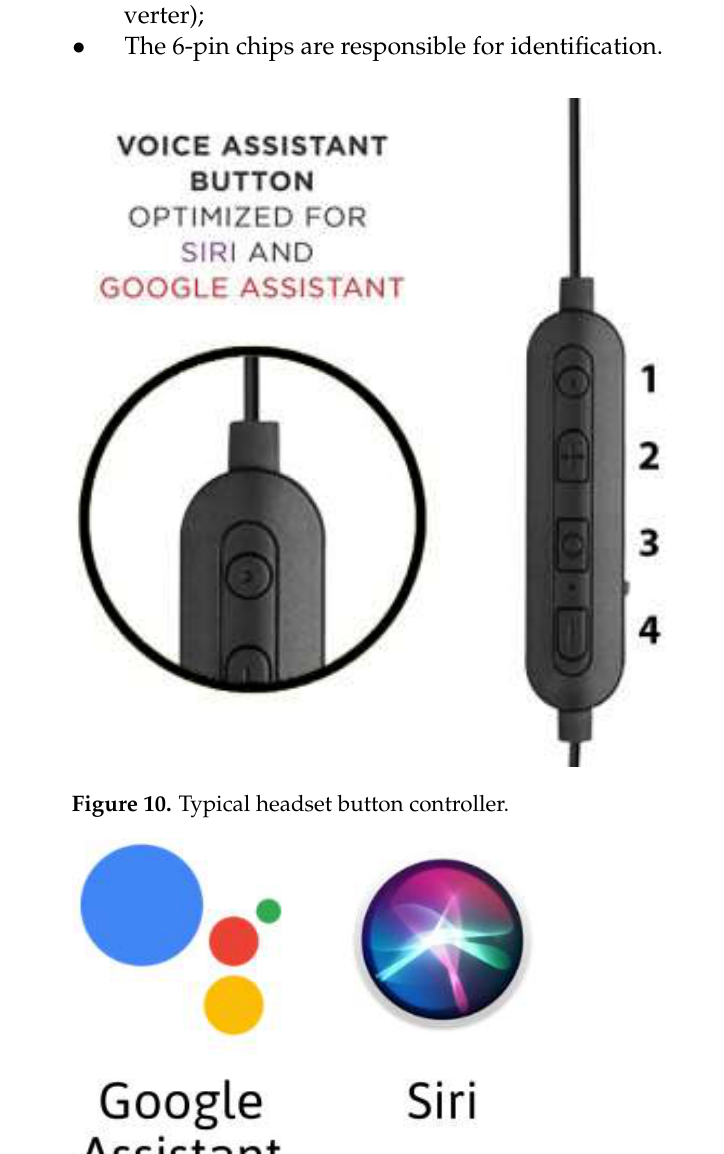
Figure 11. Differences between required devices and actions during an inaudible attack on voice assistants.